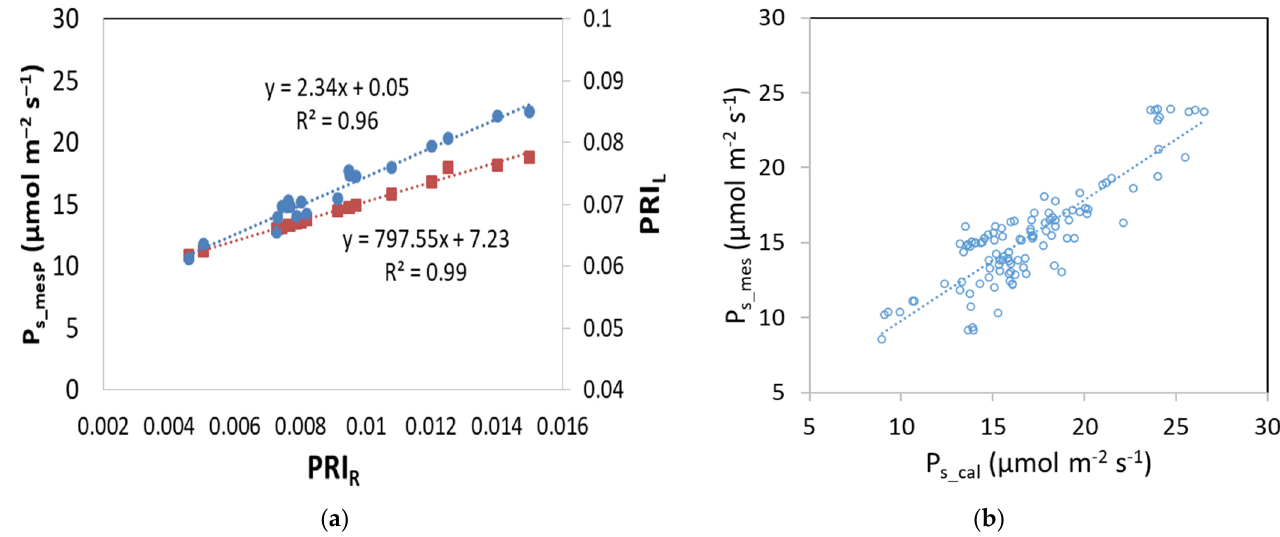
Figure 3. Relationship between ( a ) PRI R with P s _ mes and PRI L (square: P s vs. PRI R ; dot: PRI L vs. PRI R ) and between ( b ) P s_mes and P s_cal .